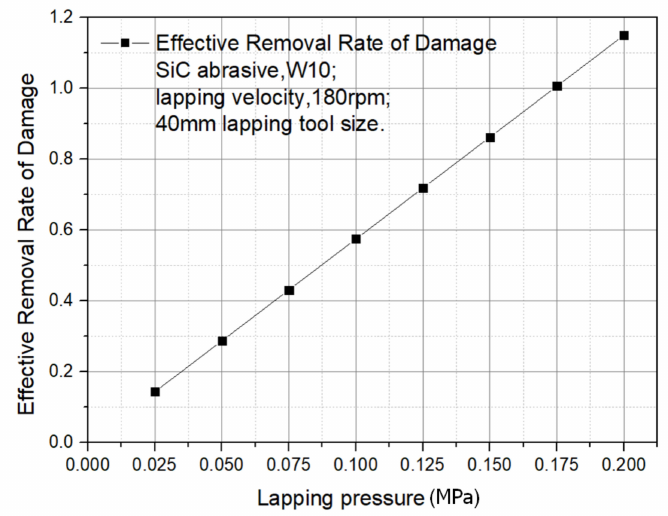
Figure 5. ERRD for various lapping pressure.